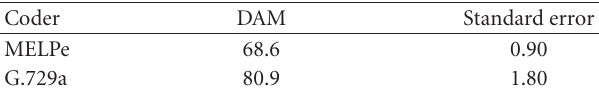
Table 3: DRT scores and standard error without environmental noise.